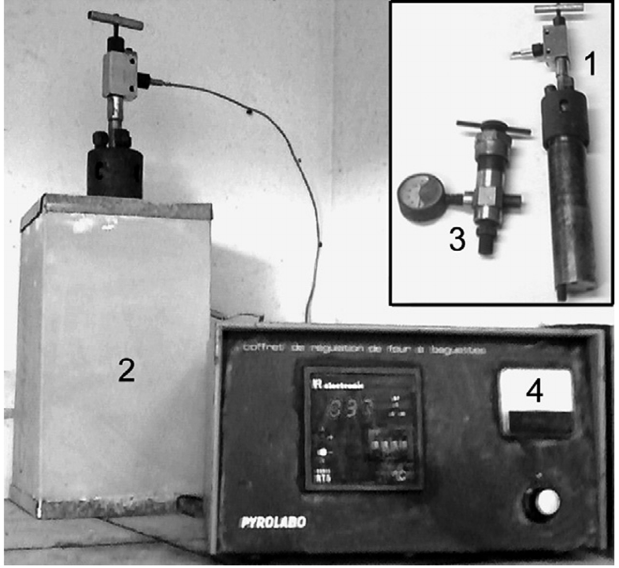
Fig. 1. Photograph of the apparatus used for supercritical extraction: (1) reactor; (2) furnace; (3) pressure gauge; (4)